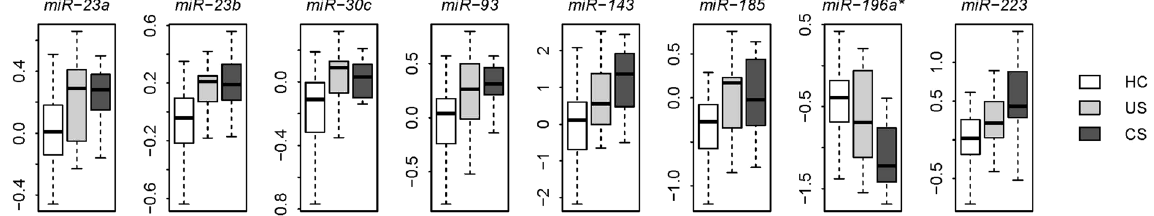
Figure 1. 8-miRNA signature in sarcoidosis. The eight miRNAs were differentially expressed with the severity of sarcoidosis. Y-axis indicates the miRNA expression level. HC: healthy controls; US: uncomplicated sarcoidosis; CS: complicated sarcoidosis.